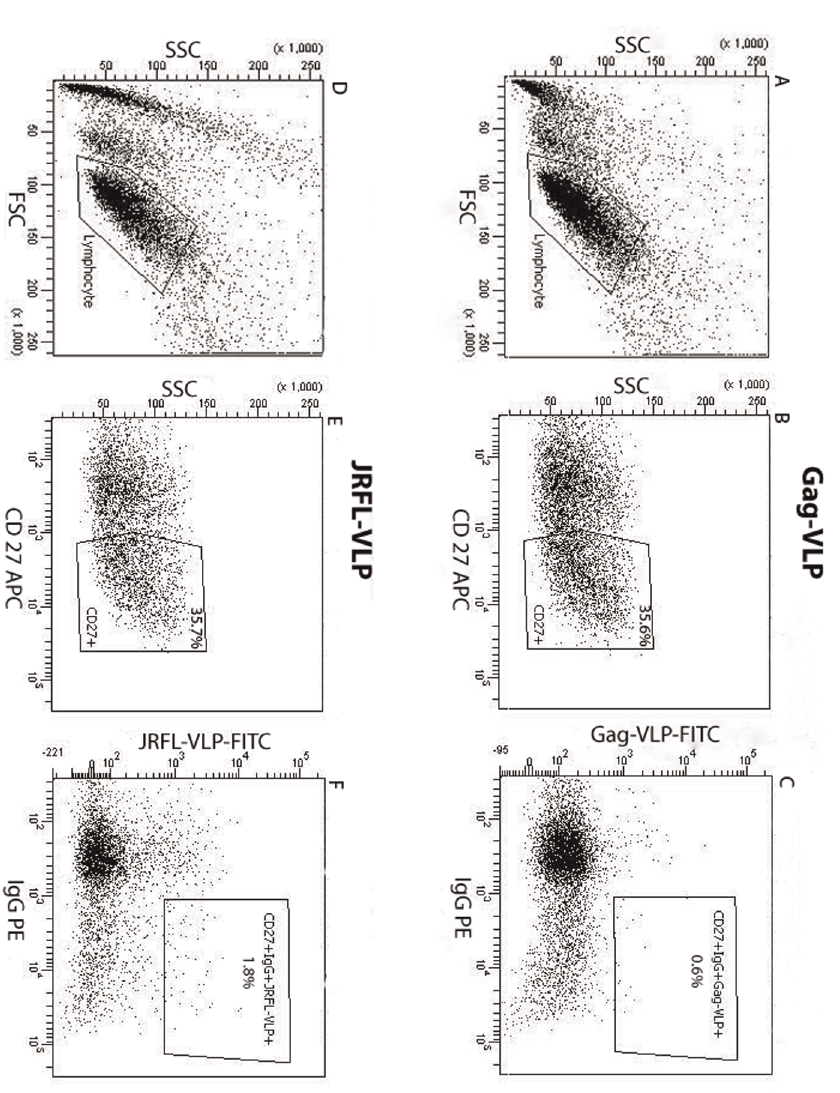
Figure 1. Cell sorting of B cells stained with VLPs, anti-CD27, and anti-IgG . The top panel (Gag-VLP) and bottom panel (JRFL-VLP) indicate the gating of non-HIV-1 and anti-HIV-1 Env Abs expressing B cells, respectively. (1A and 1D) FSC and SSC show forward scatter and side scatter, measures of cell size and granularity. The selected area shows the gated single live cells from CD19 magnetic beads enriched B cells. (1B and 1E) The dot plots show the percentages of CD27 + memory B cells. Numbers indicate the percentage of gated cells stained with anti-CD27-APC. The percentages of CD27 + memory B cells are similar prior to VLPs + selection in both non-HIV-1 and anti-HIV Env Abs expressing cells. (1C and 1F) The dot plots show the gating of IgG + and Gag-VLP + cells (1C) or IgG + and JRFL-VLP + cells (1F) on the CD27 + memory B cells. The selected area shows percent of total B cells stained for Gag-VLP (1C) and JRFL-VLP (1F).